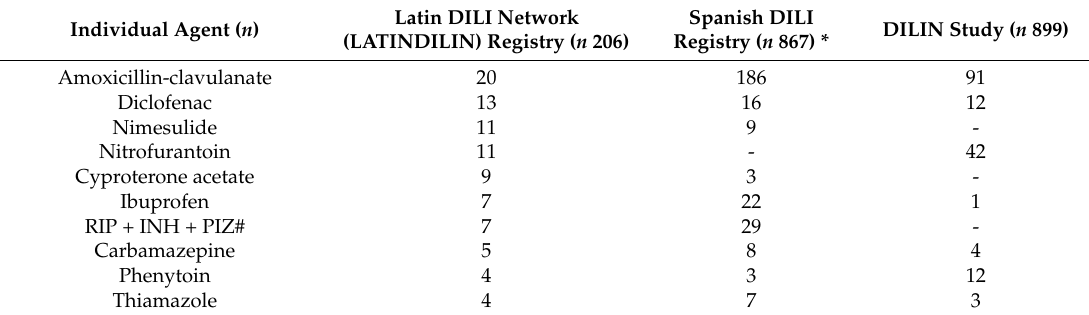
Table 2. Top ten individual agents that cause DILI in the LA Registry. Comparisons among Spanish